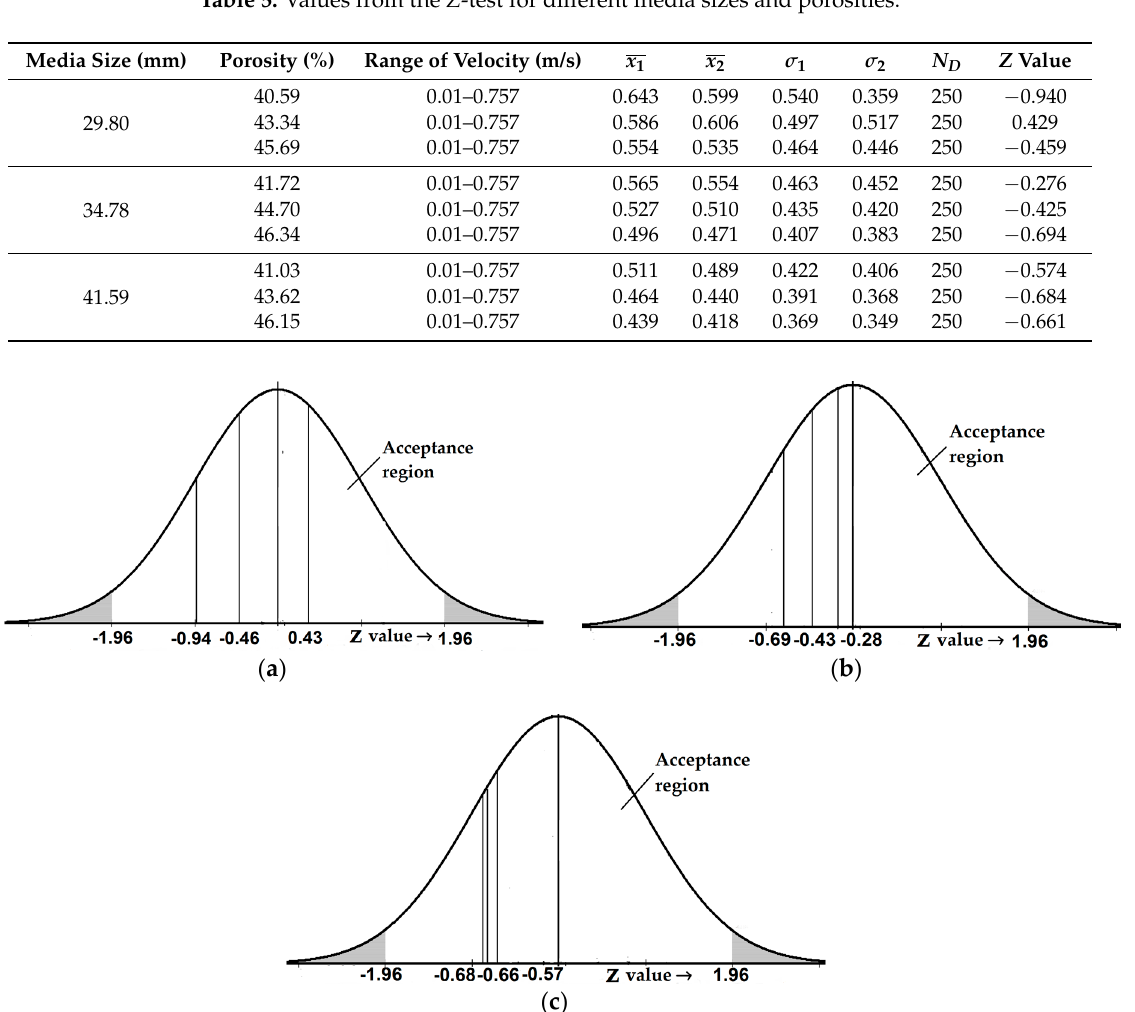
Figure 13. The Z calculated values on the binomial distribution curve for ( a ) 29.8 mm; ( b ) 34.78 mm; and ( c ) 41.59 mm media sizes.